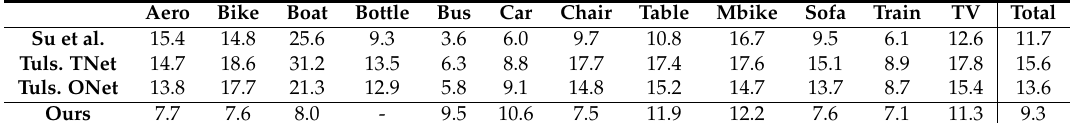
Table 2. Summary of estimation accuracy for each database category. Car Chair Table Mbike Sofa Train TV Total Su et